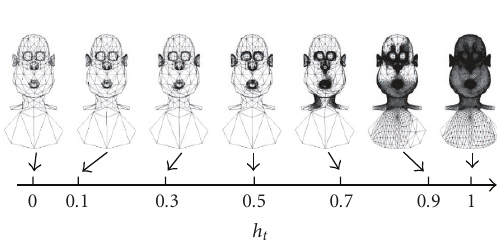
Figure 5: Continuous LOD with adaptively subdivided WSSs.